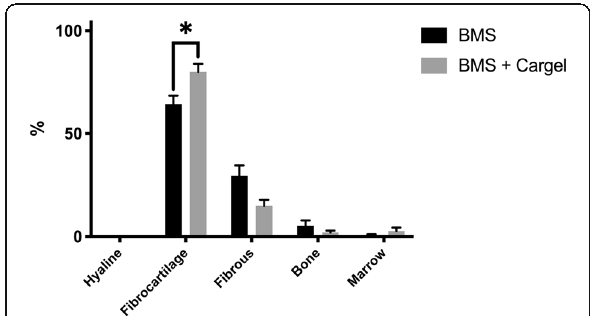
Fig. 3 Mean fraction of hyaline tissue, fibrocartilage, and fibrous tissue (+ standard error of mean (SEM)) in the cartilage repair tissue. n = 11 for each group. BMS = bone marrow stimulation. Grey bar = CARGEL Bioscaffold + BMS, black bar = BMS only.* = p <